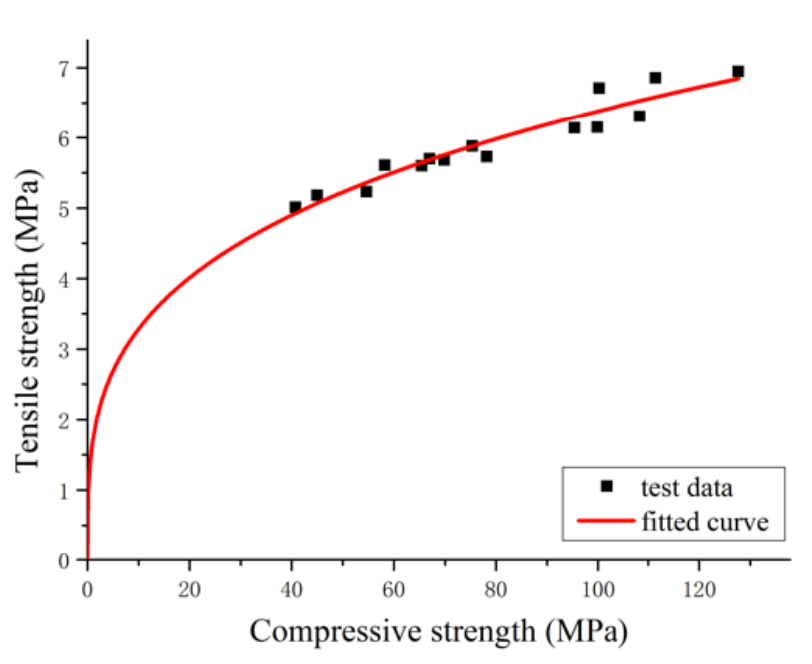
Figure 11. Relationship curve between tensile strength and compressive strength of RPC.